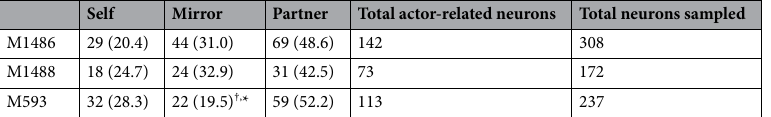
Table 2. Number of actor-related neurons in MPFC. Values in parentheses denote the percentage of total actor-related neurons. † P < 0.05, M1486 vs. M593; * P < 0.05, M1488 vs. M593; chi-square test.